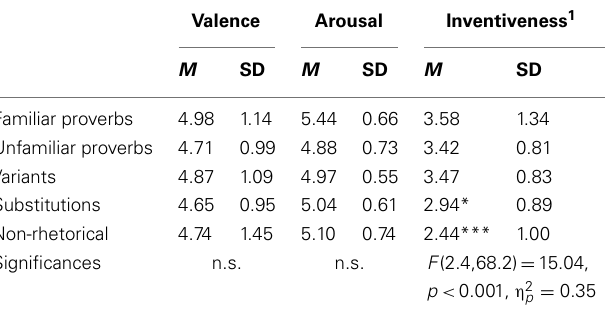
Table 3 | Pretest